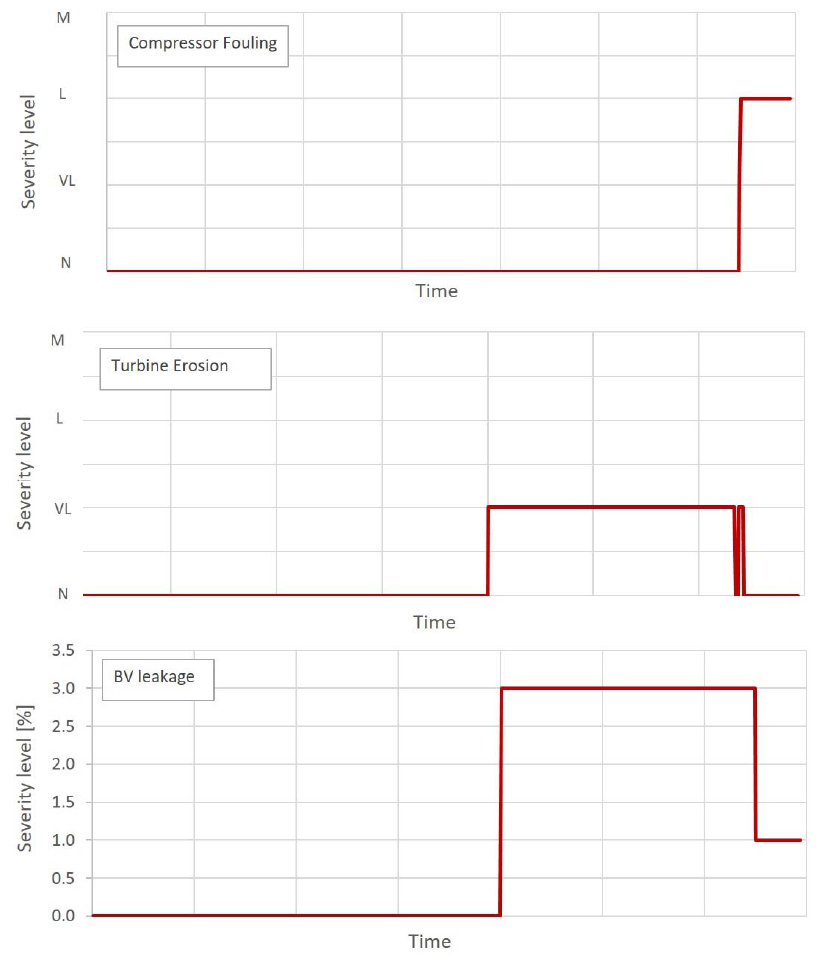
Figure 11. BN predictions of compressor fouling, turbine erosion, and BV leakage in Scenario 2.